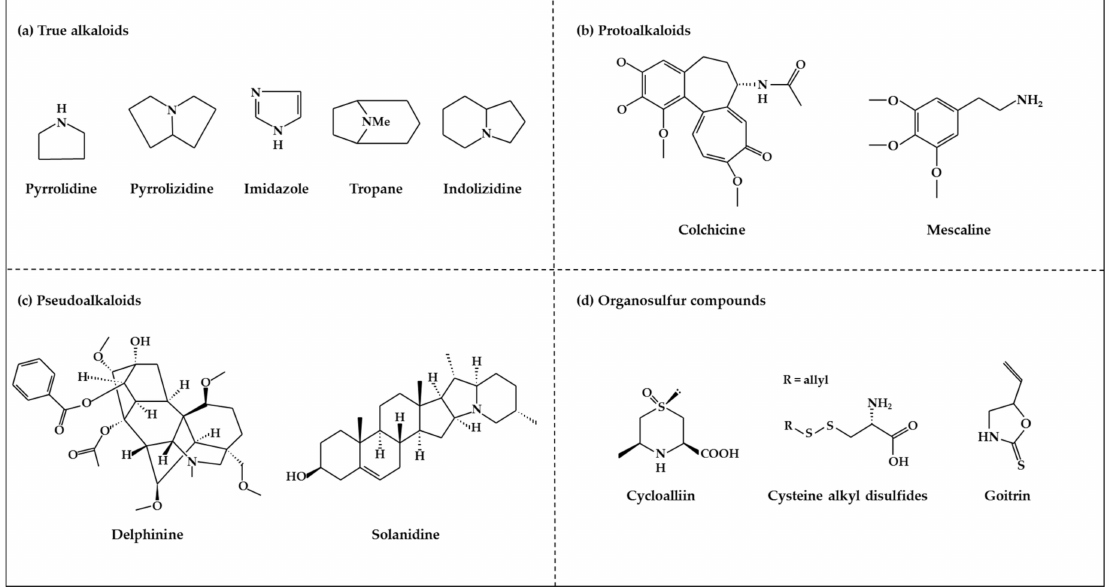
Figure 3. Structure of nitrogen-containing alkaloids and sulfur-containing